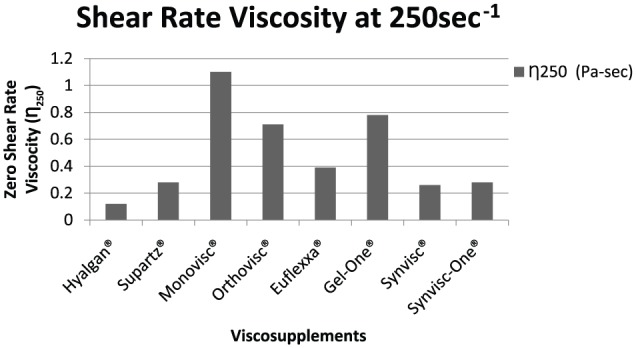
Shear rate viscosity (η250) of different viscosupplements.